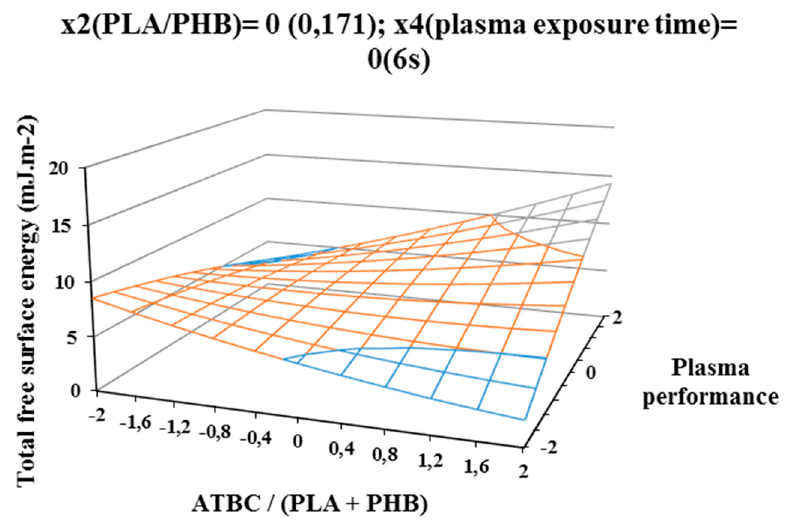
Figure 3. Response surface of total free surface energy difference measured immediately after plasma surface treatment in dependence of factors x1(ATBC/(PLA+PHB)) and x3 (plasma performance) at constant factor x2 (PHB / PLA) = 0 and x4 (plasma exposure time) = 0.